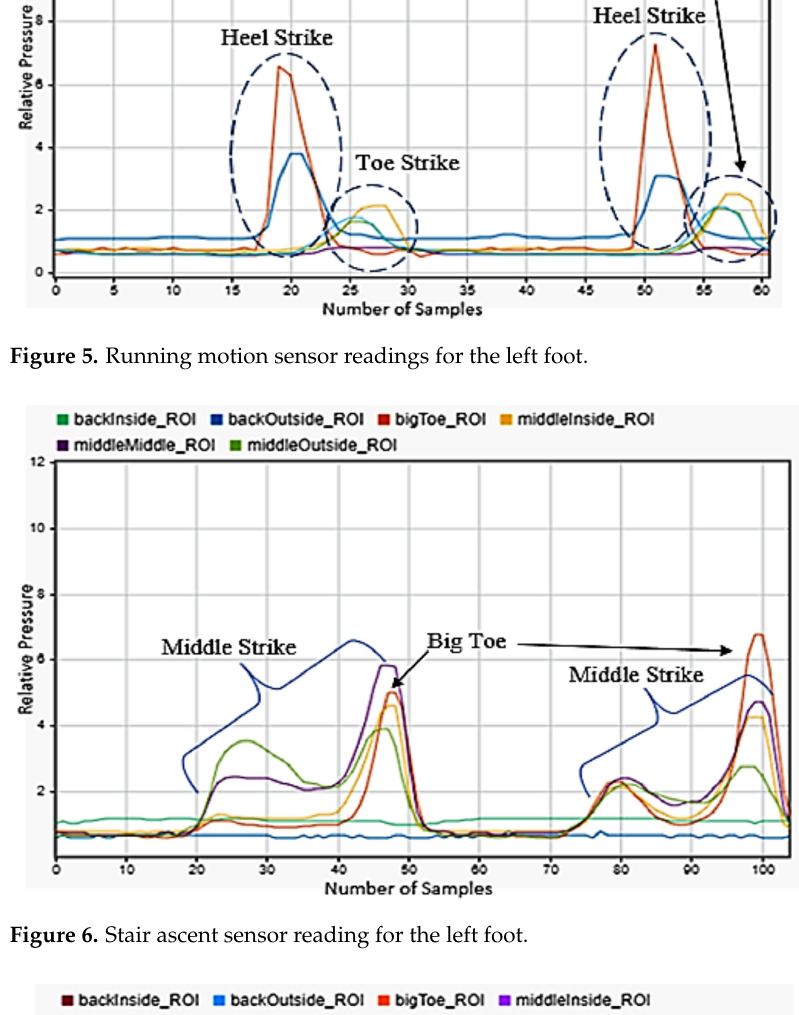
Figure 5. Running motion sensor readings for the left foot.